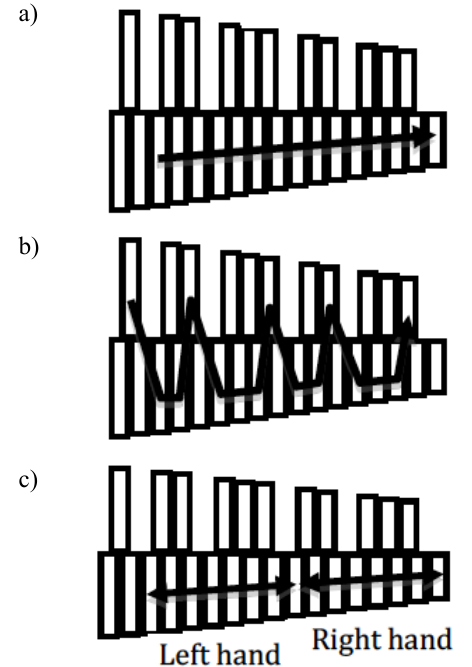
Figure 3. Top-view of the trajectory of the hands/mallets of the percussionist for different musical tasks: a) hands playing in strict alternation in a straight line (C-major scale); b) hands playing in strict alternation along a jagged-line to reach altered notes (B-flat major scale); c) hands playing in strict alternation but going in opposite directions back and forth from a central note (C) along the C-Major